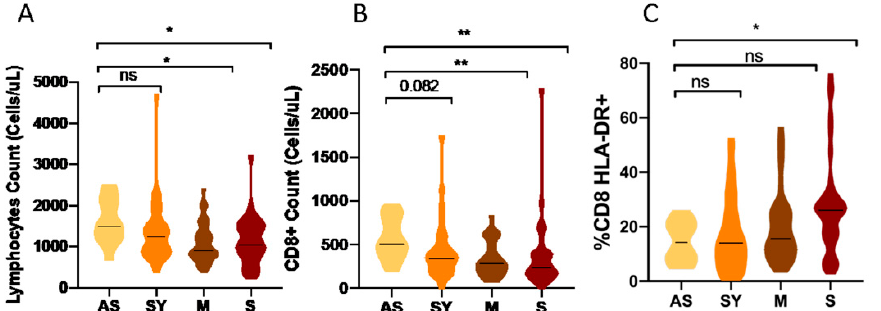
Figure 4. Lymphocytic comparison of asymptomatic COVID-19 patients vs. symptomatic ones. ( A ) Lymphocyte count (cells/µL) ( B ) Number of CD8+ (cells/µL) T cells ( C ) Percentage of activated (HLA-DR+) CD8+ T cells. AS; asymptomatic COVID-19 patients, SY; symptomatic COVID-19 pa- tients without hospitalization requirements, M; mild to moderate hospitalized COVID-19 patients and S; Severe COVID-19 patients. ns, not-significant; * p < 0.05; ** p < 0.01.